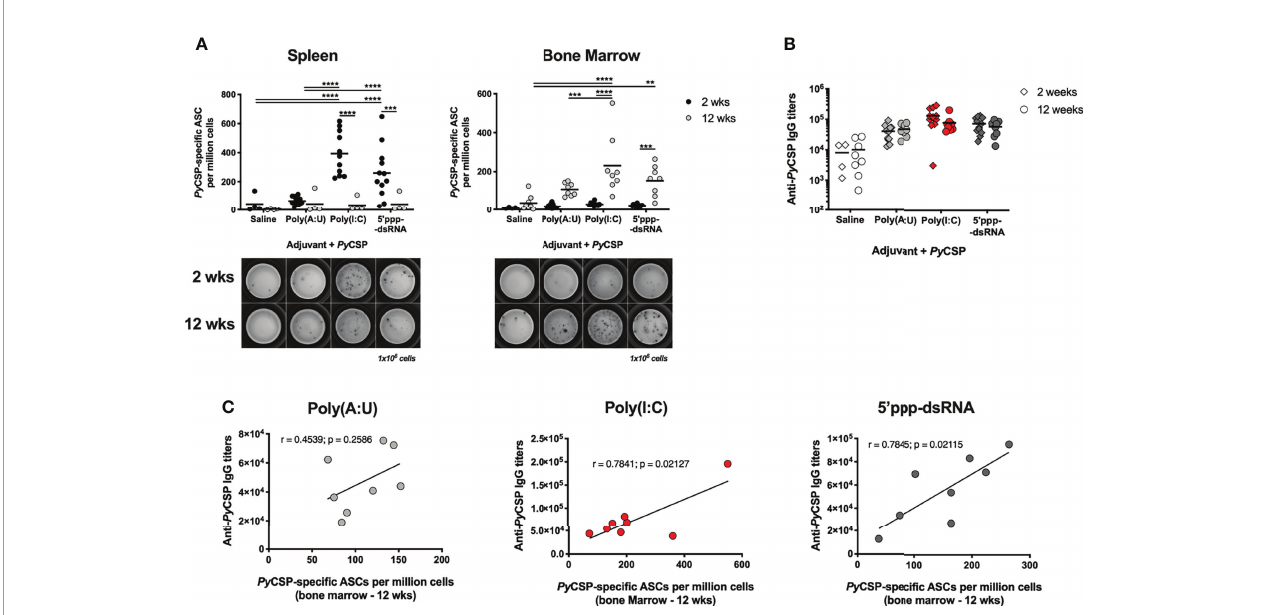
FIGURE 4 | Antibody secreting cells induced by immunization with Py CSP in combination with different adjuvants. (A) Py CSP-speci fi c antibody secreting cells (ASCs) in the spleen (left) and bone marrow (right) of animals immunized with Py CSP in saline or in combination with different adjuvants, 2 and 12 weeks after booster immunization. Symbols represent individual values and black lines the mean of each group, obtained from three (2 weeks timepoint, n = 12) and two (12 weeks timepoint, n = 8) independent experiments. Below the graphs, a representative image of the ELISpot for each condition is shown. (B) Total anti- Py CSP IgG titers of mice immunized with Py CSP in saline or in combination with different adjuvants. Symbols represent individual values and black lines the mean of each group. (C) Correlation between the total anti- Py CSP IgG titers and the number of Py CSP speci fi c ASCs in the bone marrow 12 weeks post booster immunization for animals immunized with Py CSP and poly(A:U), poly(I:C) or 5 ’ ppp-dsRNA. Person ’ s correlation coef fi cients, r, and two-tailed p values were computed for each pair. Statistical signi fi cance was determined using two-way ANOVA with either Bonferroni ’ s (A) or Tukey ’ s (B) multiple comparisons test. **p ≤ 0.01; ***p ≤ 0.001; ****p ≤